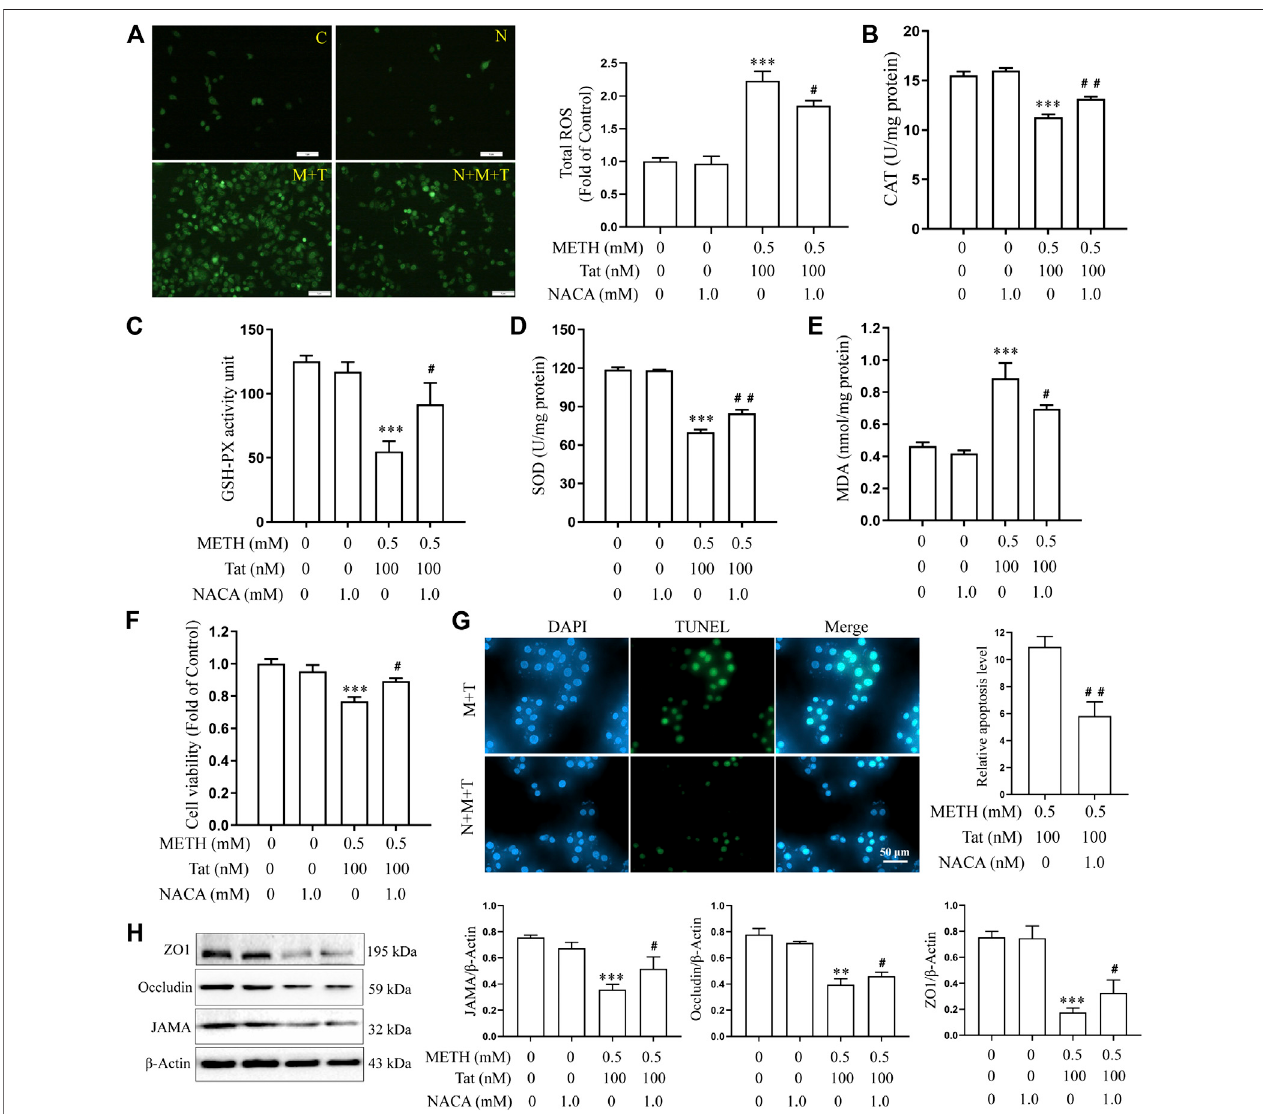
FIGURE 3 | METH and HIV-Tat synergistically induce oxidative stress that damages the BBB model in vitro . The hCMEC/D3 cells were treated with or without 1.0 mM of NACA for 1 h before 0.5 mM of METH and 100 nM of HIV-Tat for 24 h. (A) ROS fl uorescence was observed by an inverted fl uorescence microscope (Scale bar: 1 µm), and the fl uorescence intensity was analyzed by Image J software; (B – E) the activity of CAT, GSH-PX, and SOD and the MDA level were measured using commercial kits; (F) the cell viability was measured using the CCK8 kit; (G) apoptosis was assessed via TUNEL assay (Scale bar: 50 µm), apoptosis level